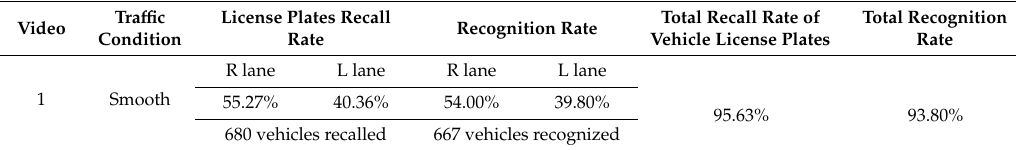
Table 2. Vehicle recall and recognition results of license